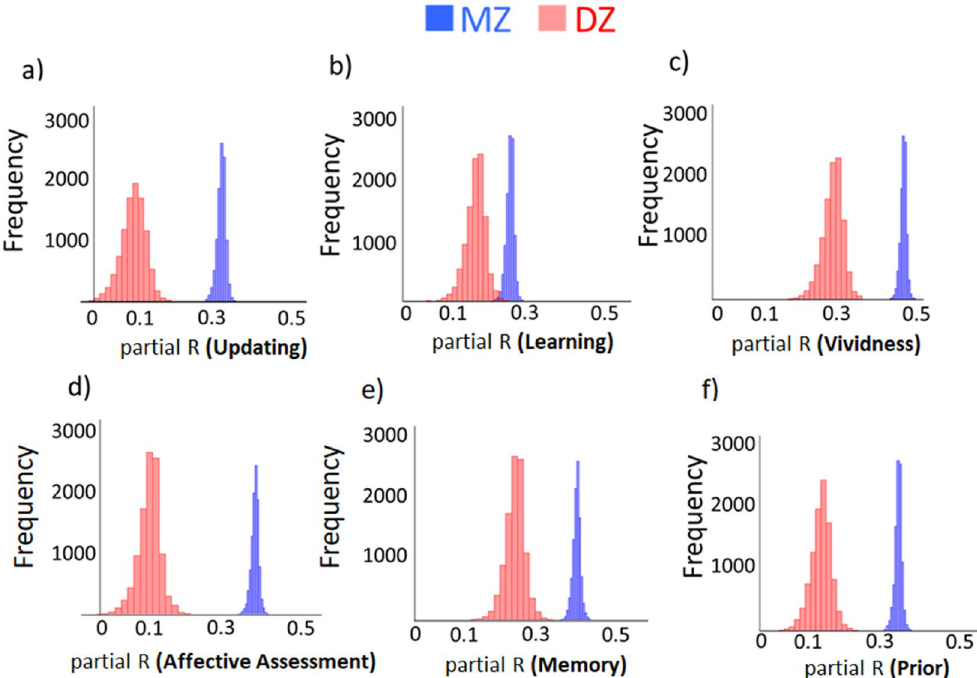
Figure 3. Distribution of cognitive and affective factors associated with beliefs. Plotted are the distributions of the partial correlation (controlling for all covariates—this means that in an analysis of one factor above we are controlling for all the other above factors) between monozygotic (blue) twin A and twin B and dizygotic (red) twin A and twin B for each variable of interest. Since assignment of twins in each pair to the abscissa or ordinate is arbitrary and this assignment influences the correlation value, we randomly reassigned each twin in the pair as twin A or twin B 10,000 times, each time obtaining a correlation coefficient for the monozygotic samples (blue) and for the dizygotic one (red). A stronger correlation for monozygotic twins’ than dizygotic twins indicate heritability of the phenotype. This is indeed observed for belief updating, learning, memory, vividness of imagination, affective assessment, and priors (i.e. first estimate). Note that the width of the distribution for MZ twins is smaller than for DZ because the N is